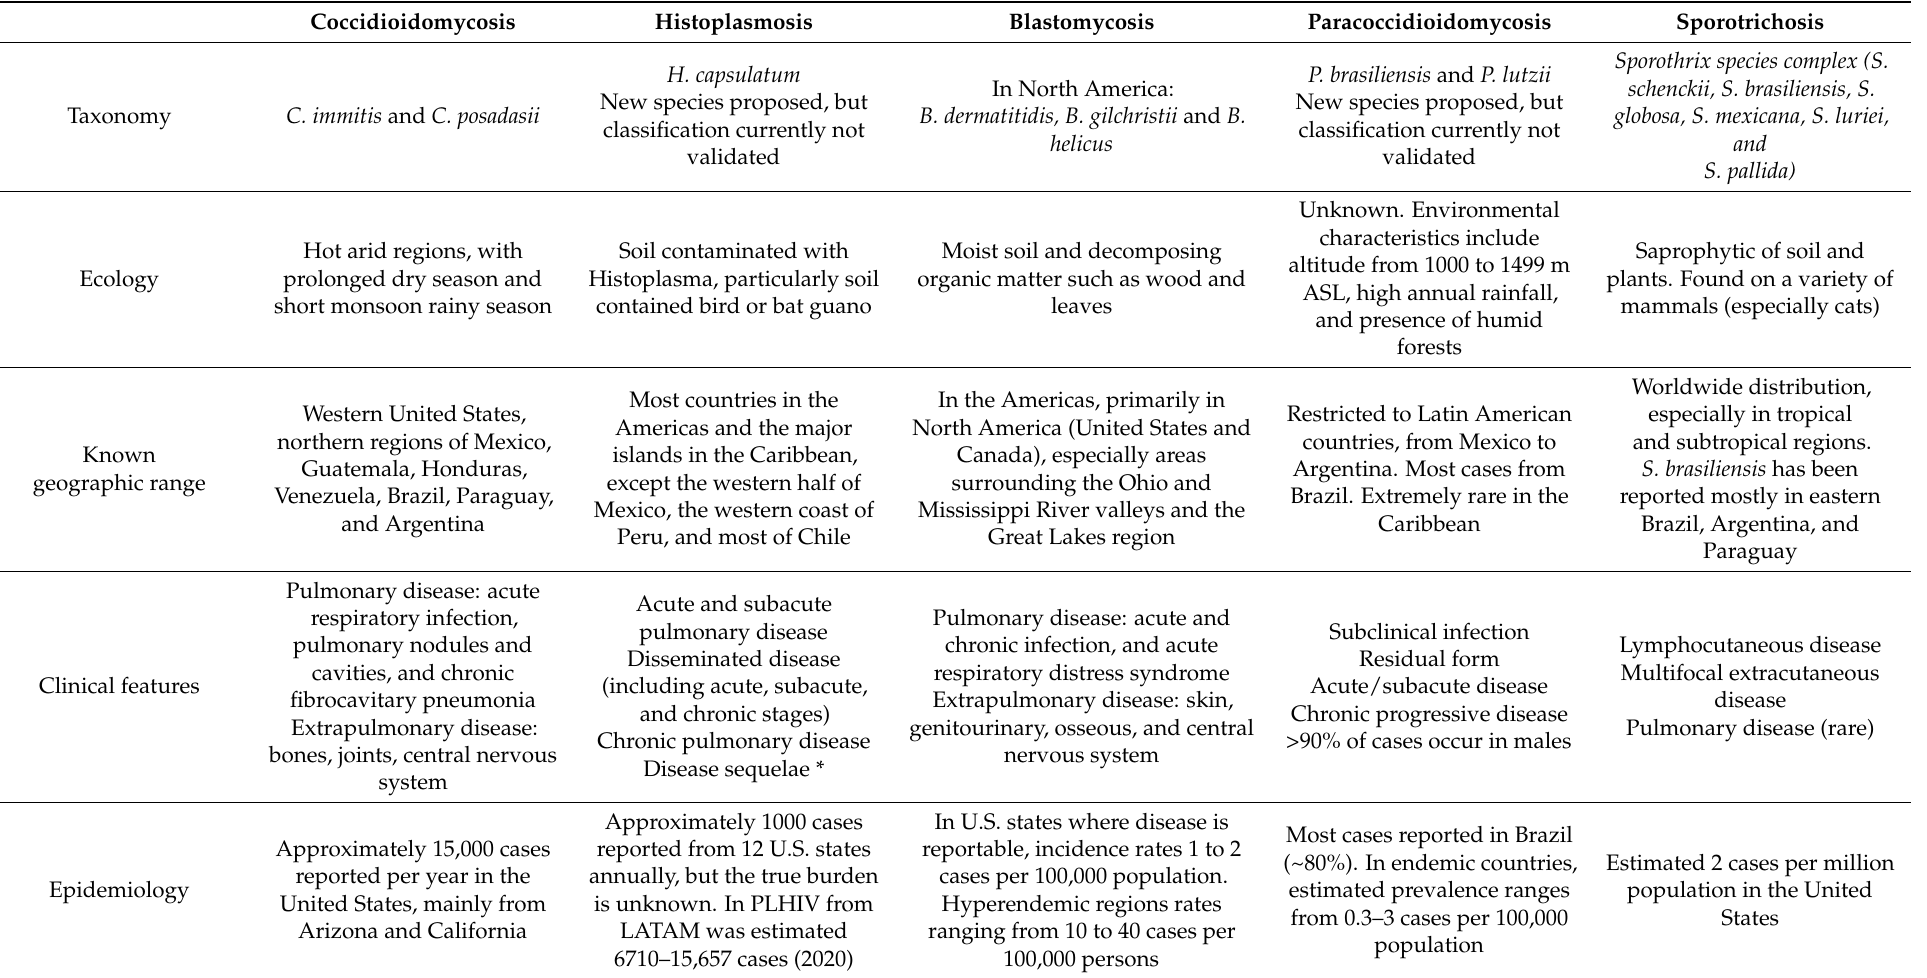
Table 1. Summary of taxonomy, ecology, geographic range, clinical features, and epidemiology of coccidioidomycosis, histoplasmosis, blastomycosis, paracoccidioidomycosis, and